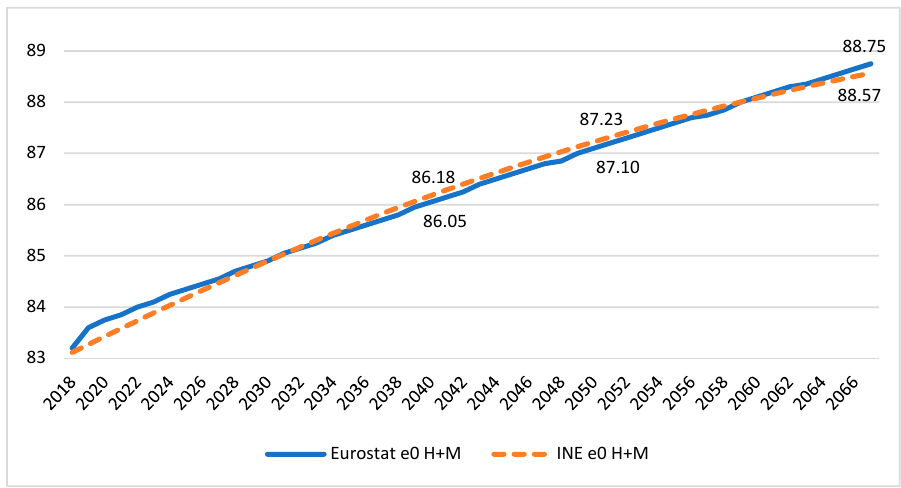
Figure 1. Life expectancy at birth. INE and Eurostat tables. Source: Prepared by the authors.